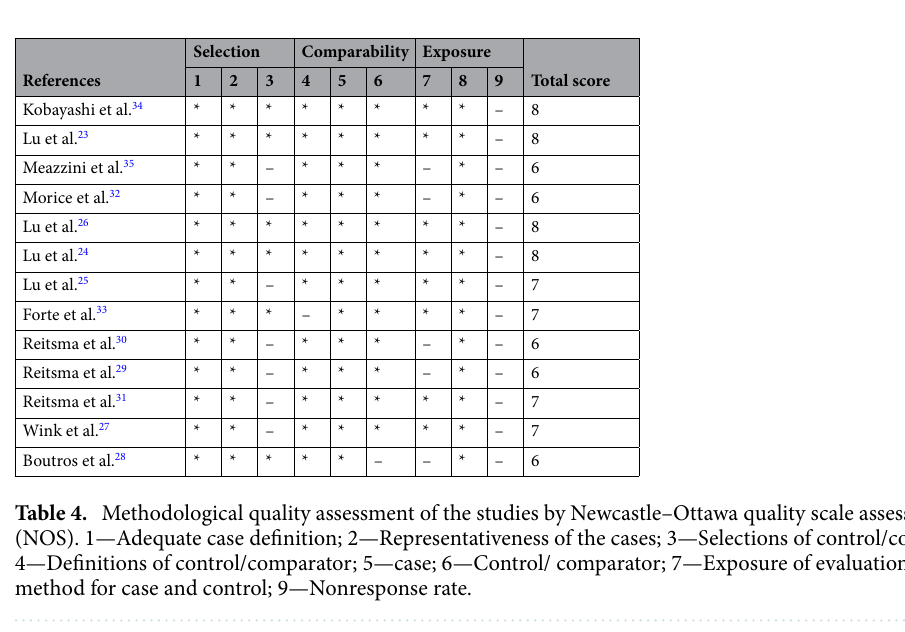
Figure 9. Galbraith plot for the outcome of ( a ) SNA, ( b ) SNB, ( c ) PPR-S-PPL, ( d ) N-S-PP, and ( e ) greater wing angle.